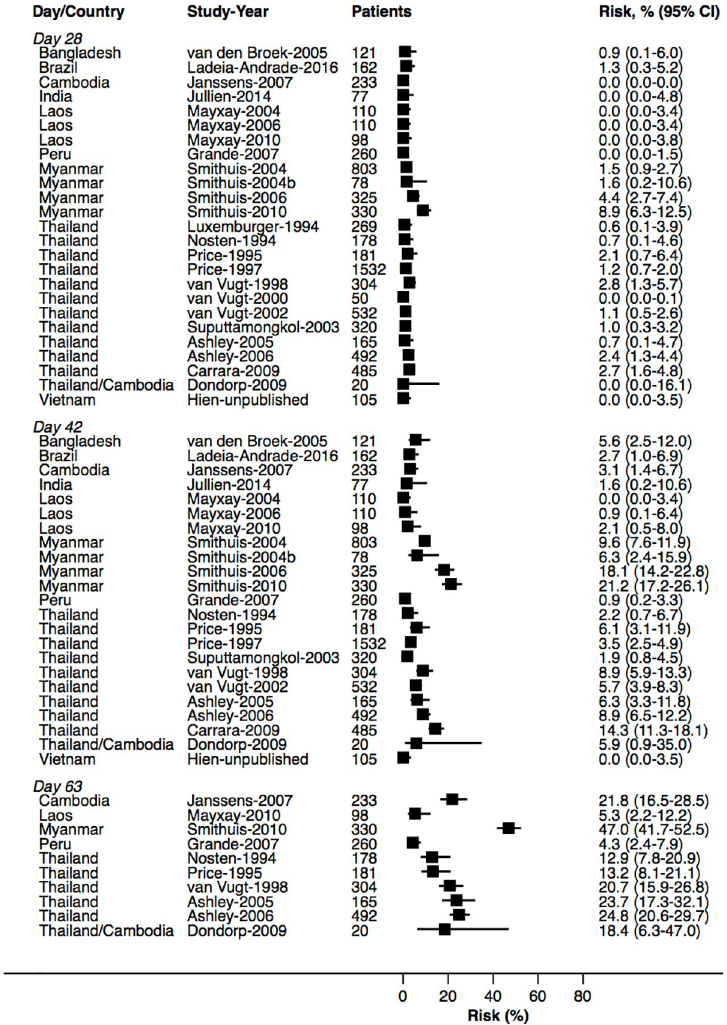
Fig 5. Cumulative risk (Kaplan–Meier analysis) of P . vivax parasitaemia after P . falciparum infection by study for AM. AM,